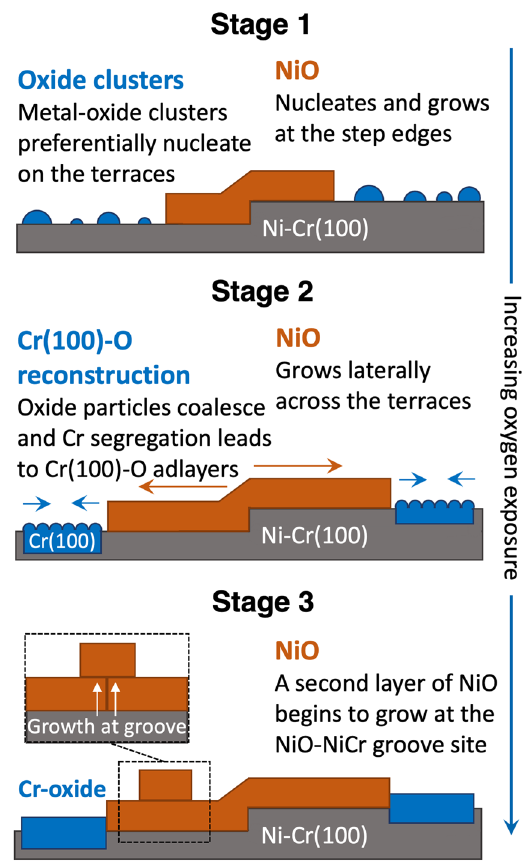
Fig. 7 A model for early-stage Ni – Cr(100) oxidation at 500 °C. Each stage of the oxidation process is highlighted with a diagram showing the evolution of each oxide product on the surface after low dosages of oxygen exposure, which increases from stage 1 to stage 3.